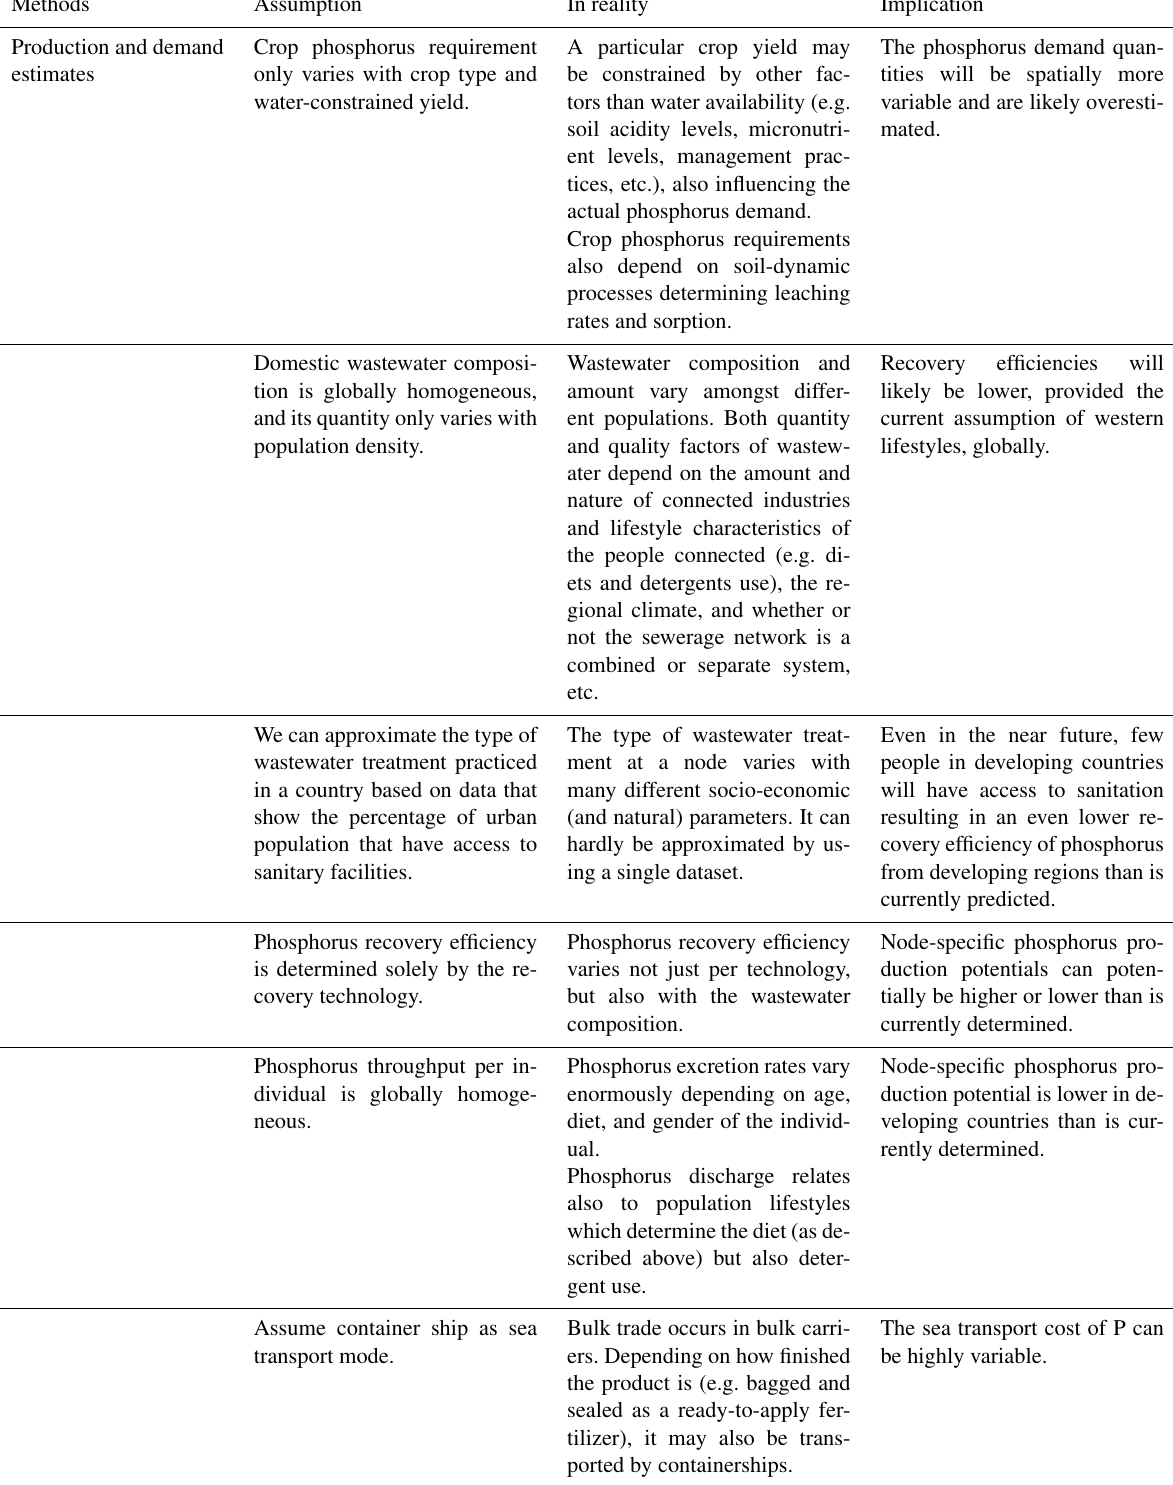
Table 3. An overview of the assumptions made in this study and their possible implications on the